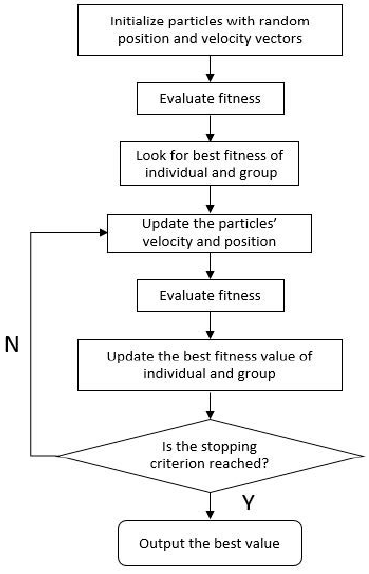
Figure 6. Multiobjective optimization control